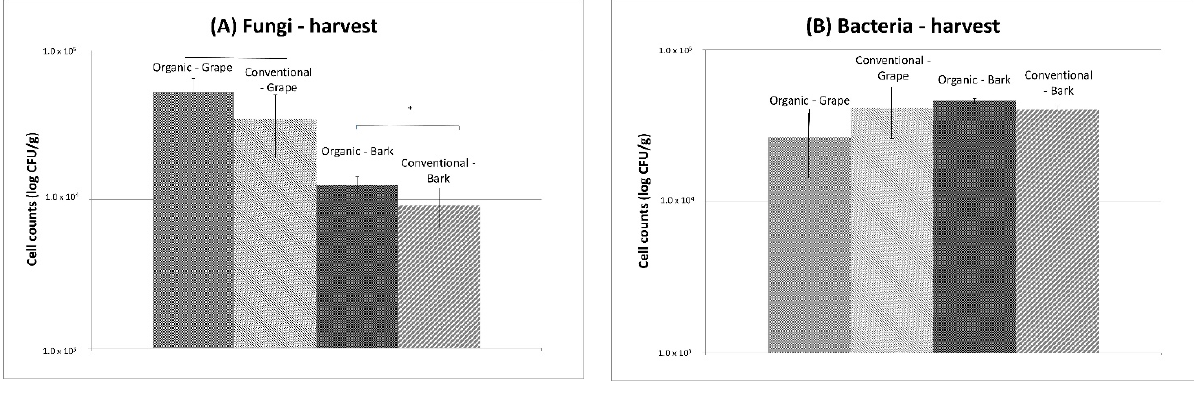
Figure 3. Agarose gel electrophoresis of HinfI restriction profiles (18 colonies out of 62). M: molec- ular marker, 100 bp ladder (Fermentas). After a search for restriction profiles in the Yeast-id database [35] for having a first species assessment and allowing for dereplication (data not shown), at least one sample for each ITS-cluster was amplified and sequenced for confirmation of species identifica- tion as described in Materials and Methods. In particular, a nucleotide BLAST search [36] on sequence results gave the most probable taxa identification. Alignments allowed a thorough taxonomic identification: species level was reached with good confidence level (identity scores above 98%) in all but one the profiles, whereas